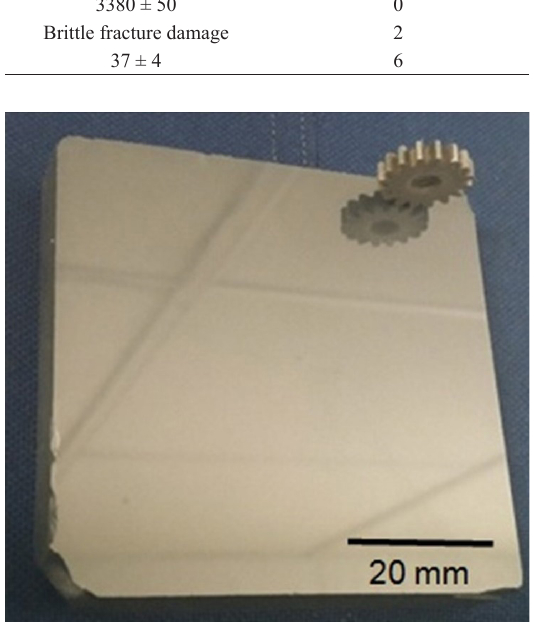
Table 4. Measured R a roughness as a function of the grinding time at 23 m/s grinding wheel speed and 10 µm depth of cut. Roughness R a